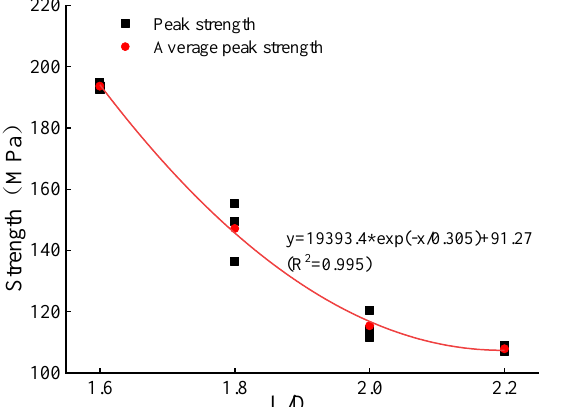
Figure 4. The peak strength of rock samples with different ratios of height−to−diameter.